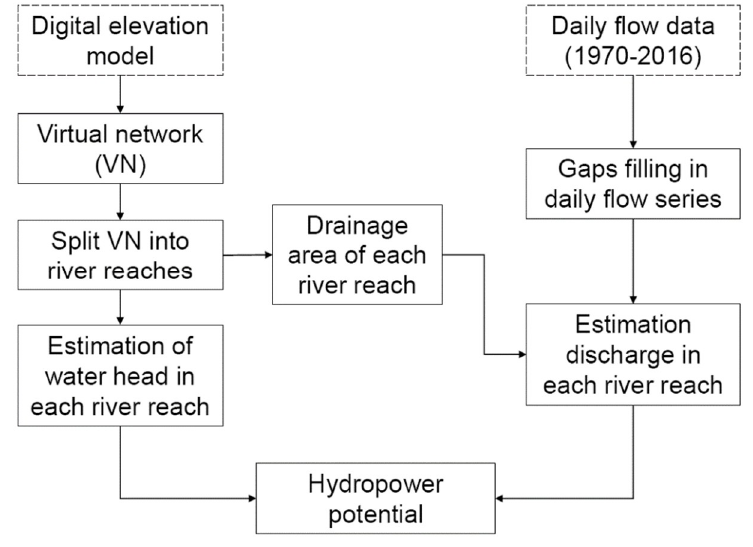
Figure 4. Flowchart for estimation of hydropower potential. Dashed lines represent the input data. 218